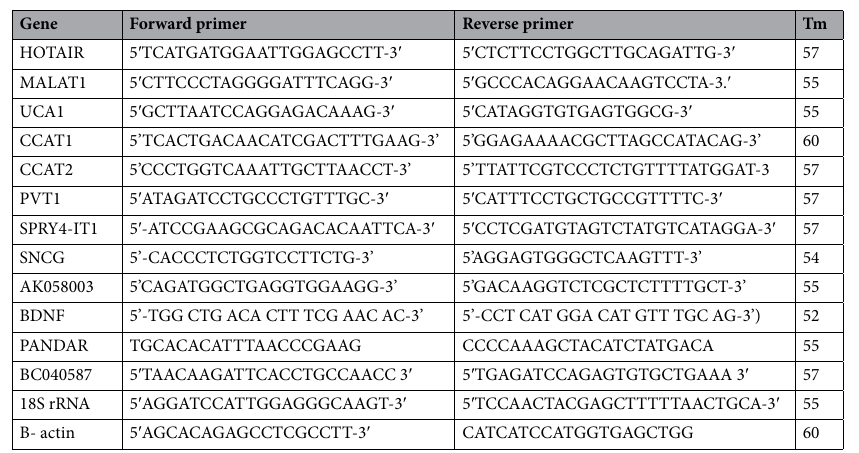
Table 2. The primers of long noncoding RNAs, mRNAs, B- actin and